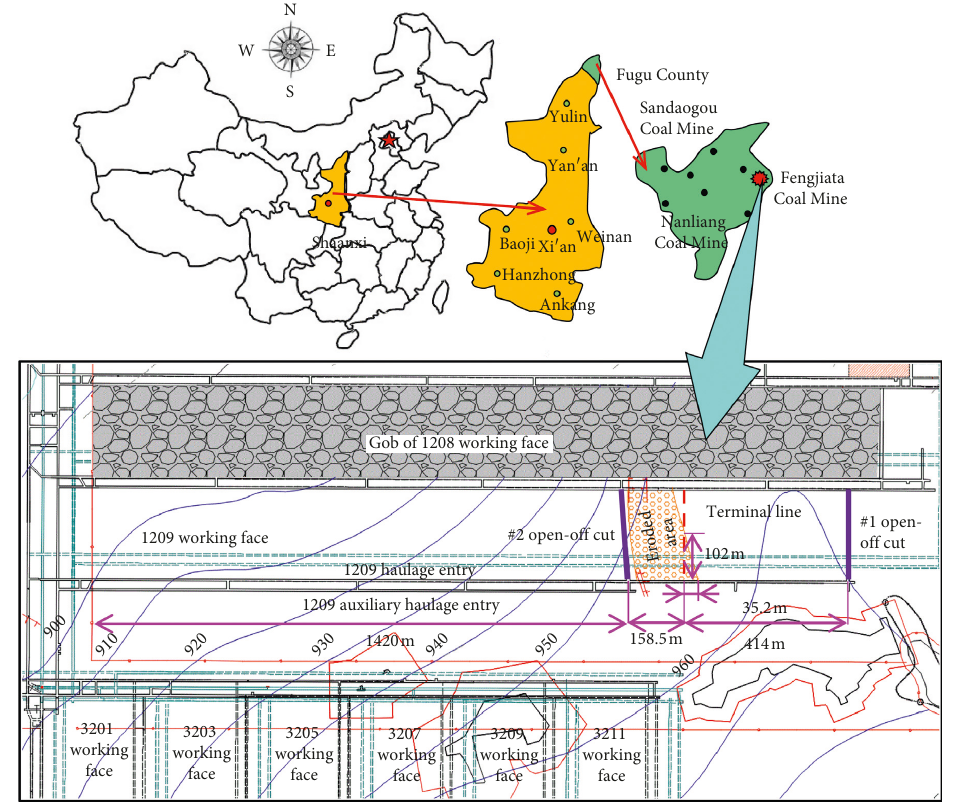
Figure 2: Geographical location of the mine and layout of the 1209 working face.